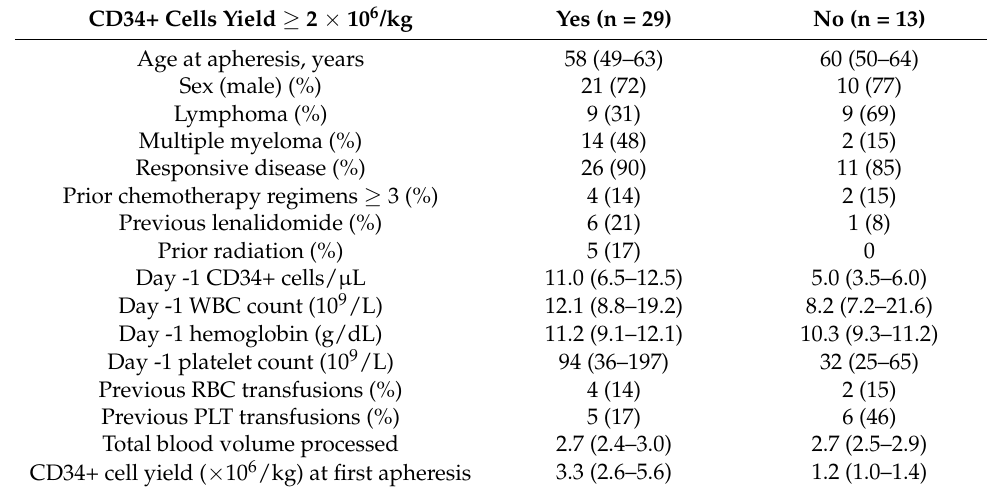
Table 2. Clinical and laboratory characteristics of patients grouped according to the completion of the target cell dose ≥ 2 × 10 6 CD34+ cells/kg at first